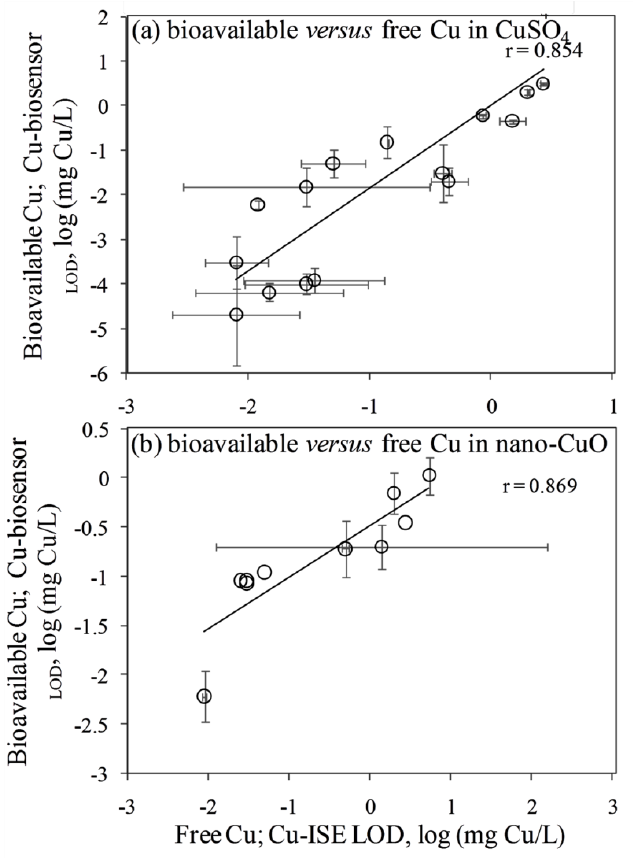
Figure 2. Correlation between limits of determination (LOD) of Cu-ISE (indicative of free Cu) and Cu-biosensor (indicative of bioavailable Cu) for CuSO in different ectotoxicological 4 and microbiological media. Data are plotted from Tables 2 and 3. ( a ) Cu-ISE and LOD Cu-biosensor for CuSO ; ( b ) Cu-ISE and Cu-biosensor for LOD 4 LOD LOD